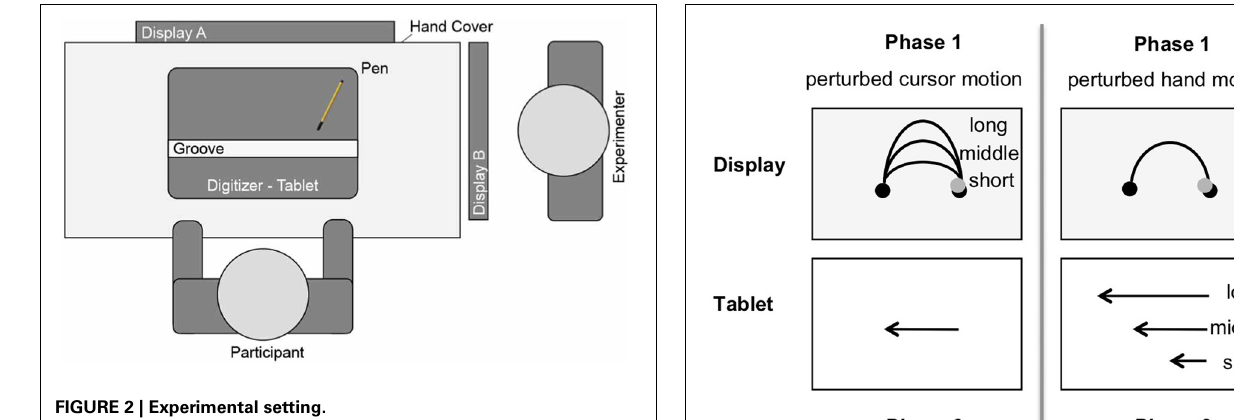
In phase 1 ( Figure 3 , upper part) of each trial two black dots (circle diameter 5.6 mm each, distance between dots 50 mm = visual target distance) and a gray circular cursor (circle diameter 4 mm) appeared on the white screen. The cursor was positioned onto the right dot, and the task in phase 1 required moving it to the dot on the far side as accurately as possible by moving the pen leftward along the groove on the digitizer tablet. The horizontal hand movement produced a ∩ -shaped cursor motion on the dis- play (i.e., the upper half of a vertical ellipse). When the cursor had reached the left dot, phase 2 ( Figure 3 , lower part) started: The screen turned blank, and participants had to move the pen back—rightward—without any visual feedback. The task in phase 2 required reproducing the initially performed hand amplitude as accurately as possible. The start position of the cursor on the left side inverted movement directions.